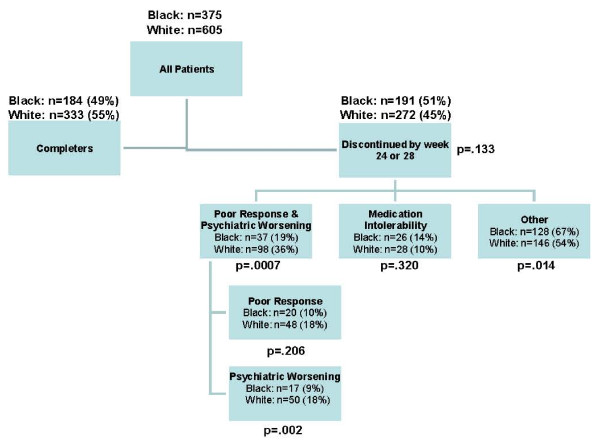
Patient disposition. Diagram summarizing patient disposition.